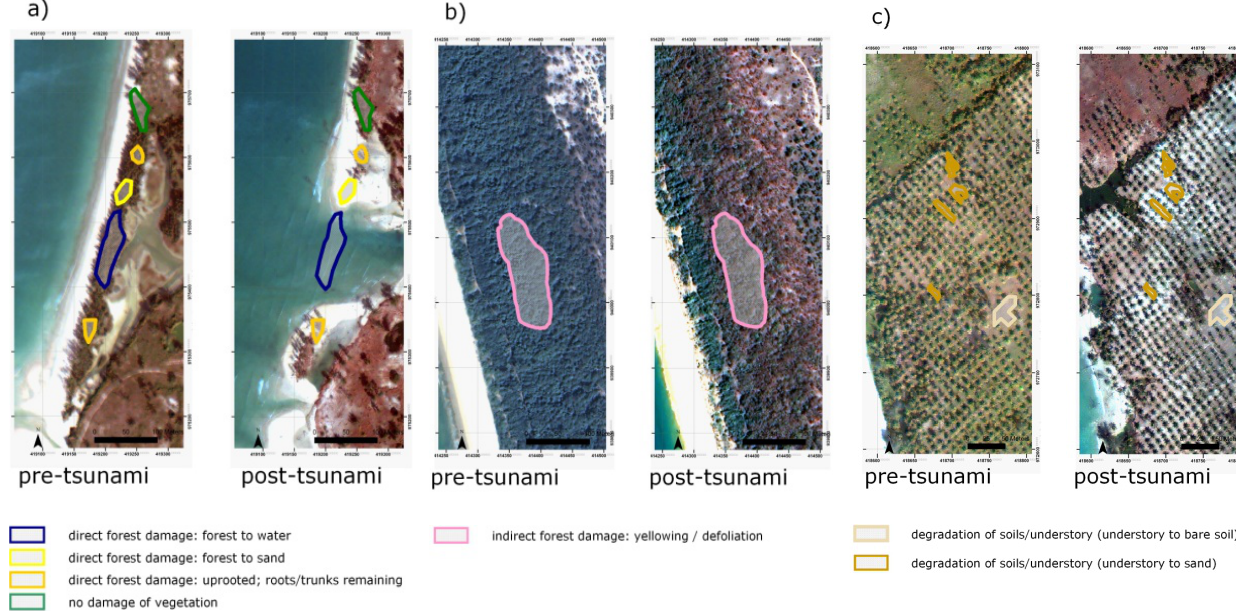
Fig. 5. Categorization of forest damage patterns.